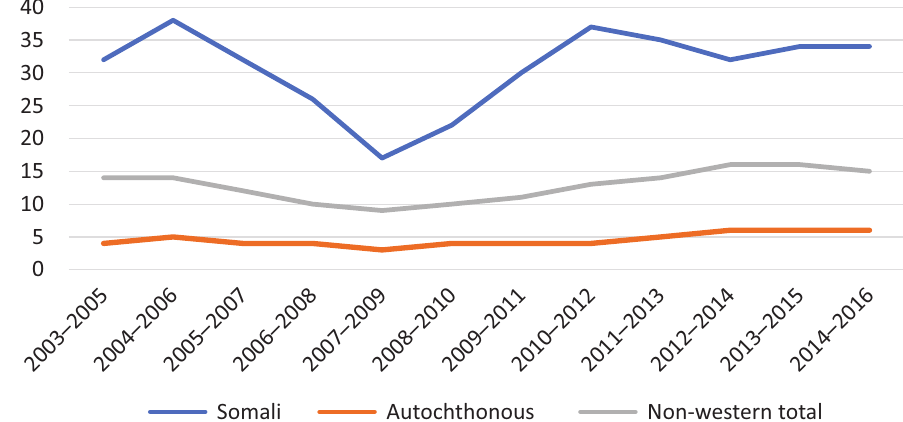
Figure 1. Unemployment figures for Somalis, autochthonous people and non-Western total, in the Netherlands 2003–2016, in percentages (based on Andriessen et al.,